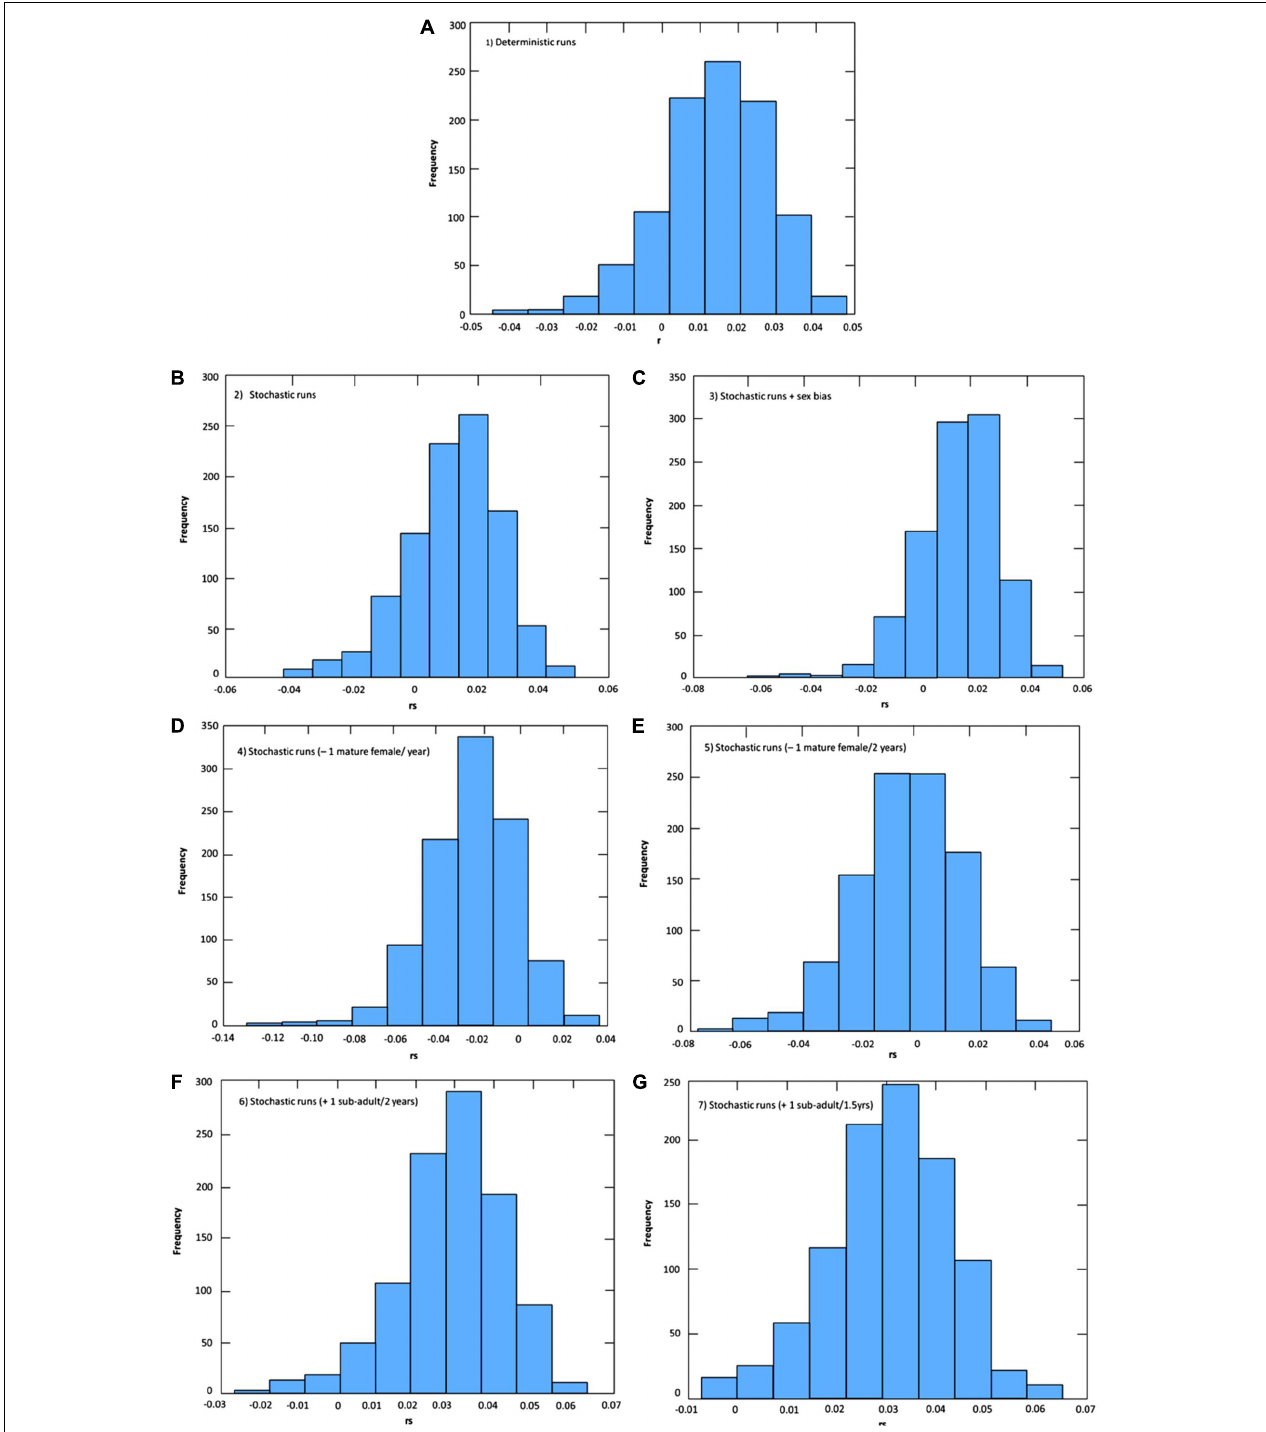
FIGURE 2 | Uncertainties in population growth rates (r: deterministic; rs: stochastic) estimations for the Lahille’s bottlenose dolphin population of the Patos Lagoon estuary under different levels of by-catch and initial number of females (scenario 3). (A) Scenario 1: Deterministic under current levels of by-catch; (B) Scenario 2: Stochastic under current levels of by-catch; (C) Scenario 3: Stochastic under current levels of by-catch and unbalanced adult sex ratio; (D) Scenario 4: Decreasing survival; removal of one mature female per year from the Patos Lagoon estuary’s dolphin population; (E) Scenario 5: Decreasing survival; removing one mature female every 2 years from the dolphin population; (F) Scenario 6: Increasing survival; avoiding the bycatch of one juvenile from the dolphin population every 2 years; Scenario (G) 7: Increasing survival; avoiding the bycatch of two juveniles from the dolphin population every 3 years.